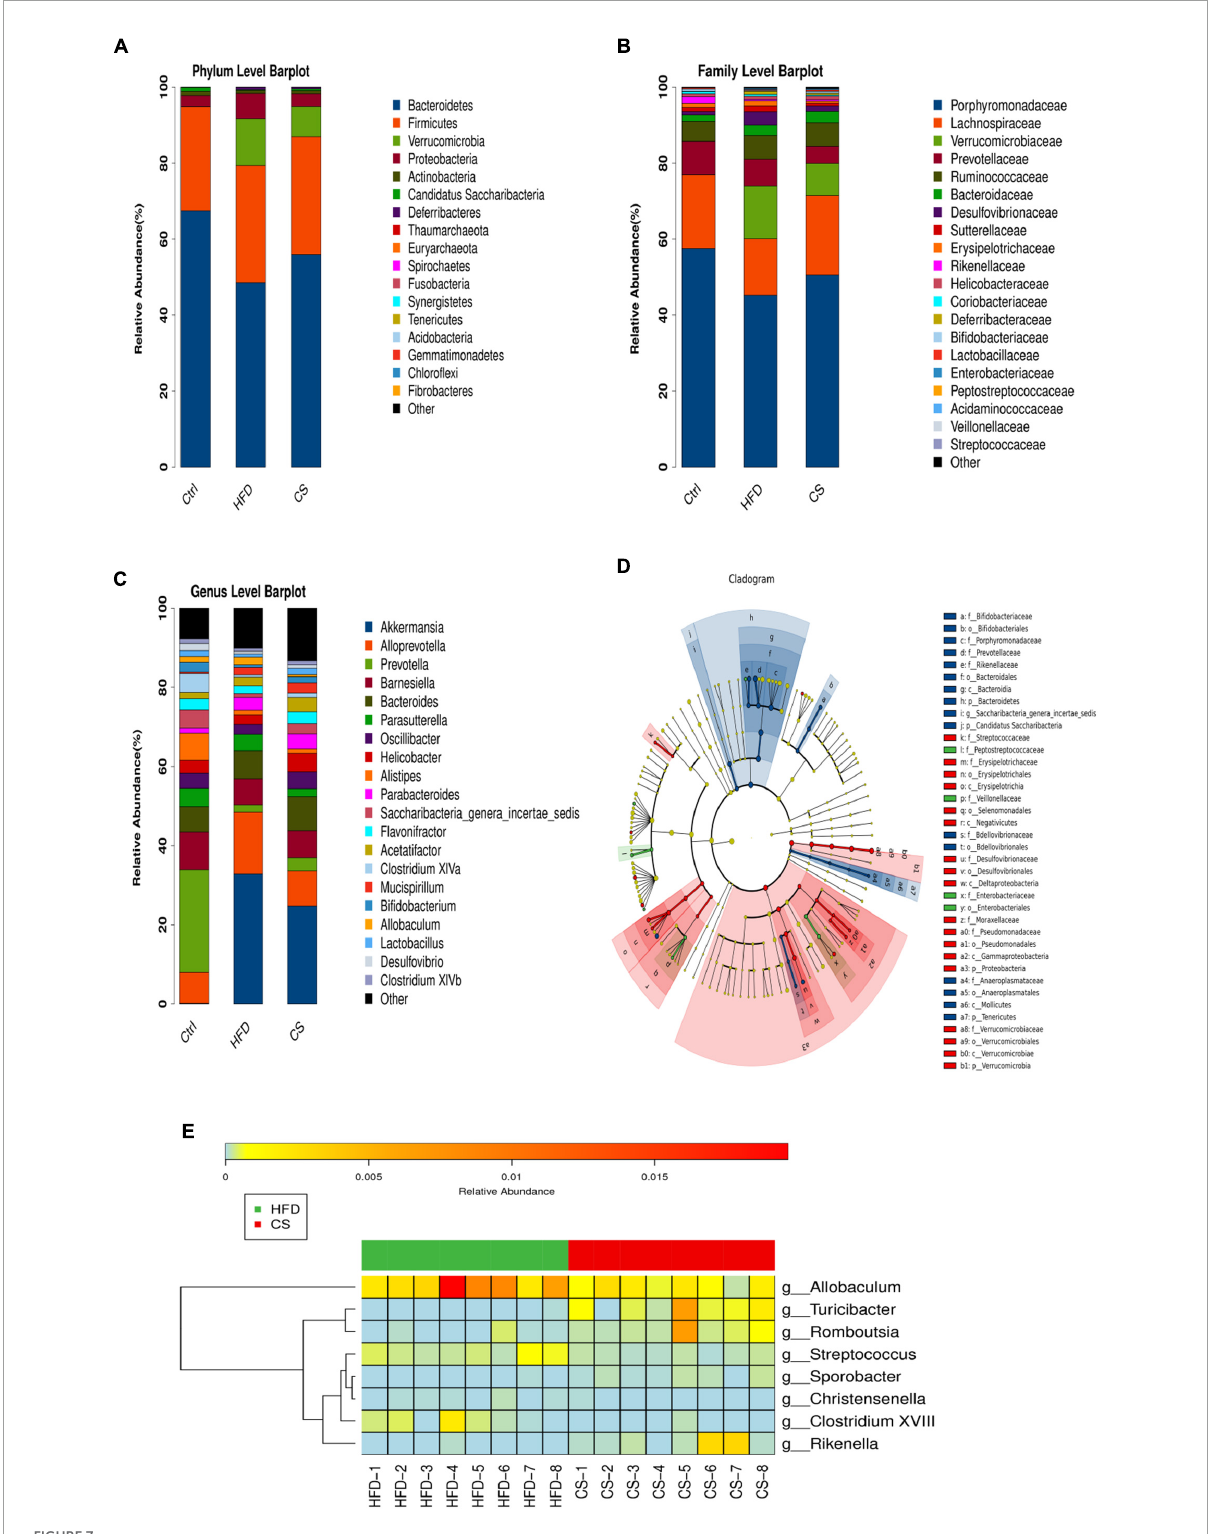
FIGURE7 Comparison of community composition. (A) Microbial community bar plot at the phylum level; (B) microbial community bar plot at the family level; (C) microbial community bar plot at the genus level; (D) LDA effect size; (E) heatmap of significant differences microbiota at the genus level. Control diet (Ctrl) group, high- fat diet (HFD) group, corn silk (CS)